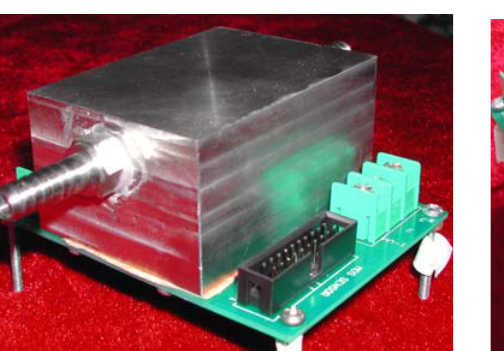
Figure 3. The electronic nose (left) and its sensor array